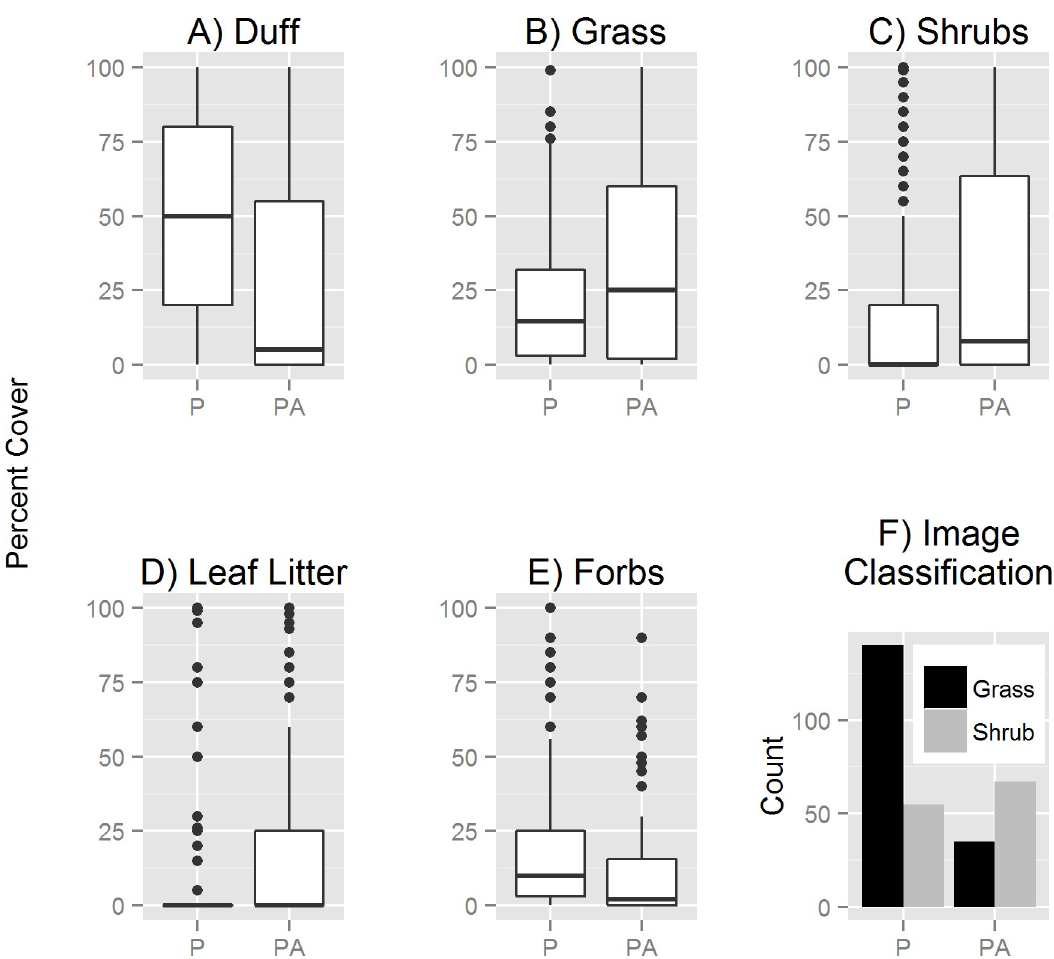
Fig 3. Habitat characteristics of spadefoot burrow locations. Habitat characteristics within 1 m 2 of spadefoot burrow locations (P) and pseudoabsence (PA) locations in Orange County, California, USA, in 2012. Percent cover of A) duff, B) grass, C) shrubs, D) leaf litter, and E) forbs, in addition to F) the classification from high spatial resolution imagery of each presence or pseudoabsence point as “grass” or “shrub.” (Two other cover classes are not shown: tree cover, which is rare at our sites, and open ground, which is the complement to grass, leaf litter, and duff: they sum to